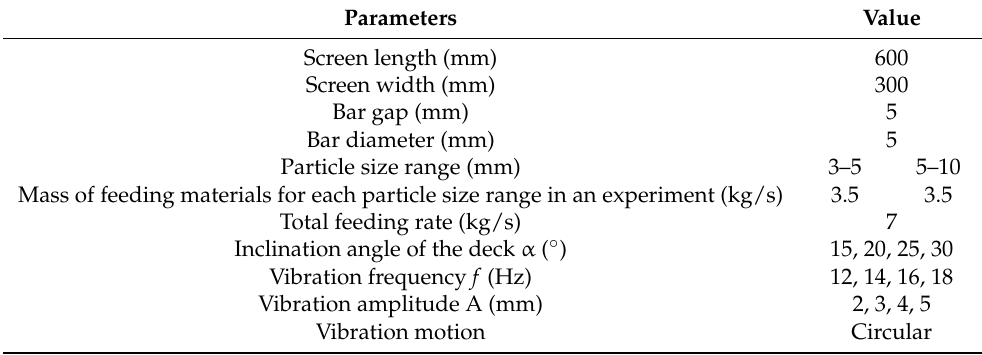
Table 2. The screening and operational parameters used in the